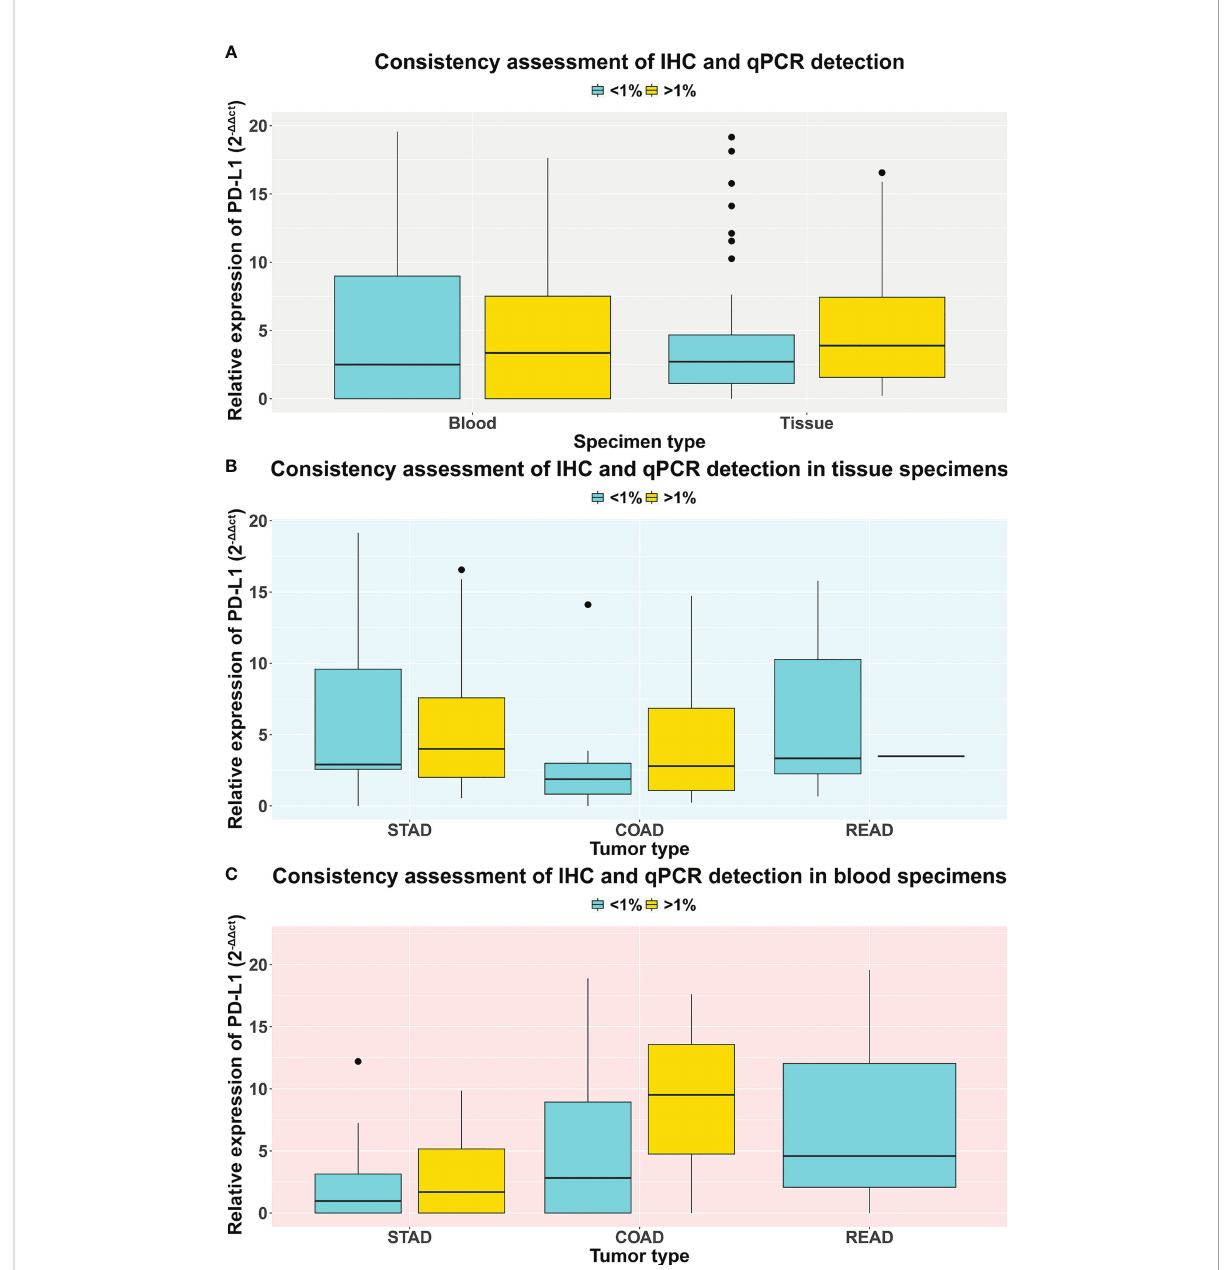
FIGURE 4 The comparison of PD-L1 expression level quali fi ed by IHC and qRT-PCR methods. Each patient was grouped into a high (> 1%) and low (< 1%) cohort based on their IHC results of PD-L1 expression. (A) The comparison of PD-L1 expression level between tissue and blood specimens via qRT-PCR test. (B) The comparison of PD-L1 expression level between stomach, colon, and rectum adenocarcinoma patients via qRT-PCR test on tissue specimens. (C) The comparison of PD-L1 expression level between stomach, colon, and rectum adenocarcinoma patients via qRT- PCR test on blood